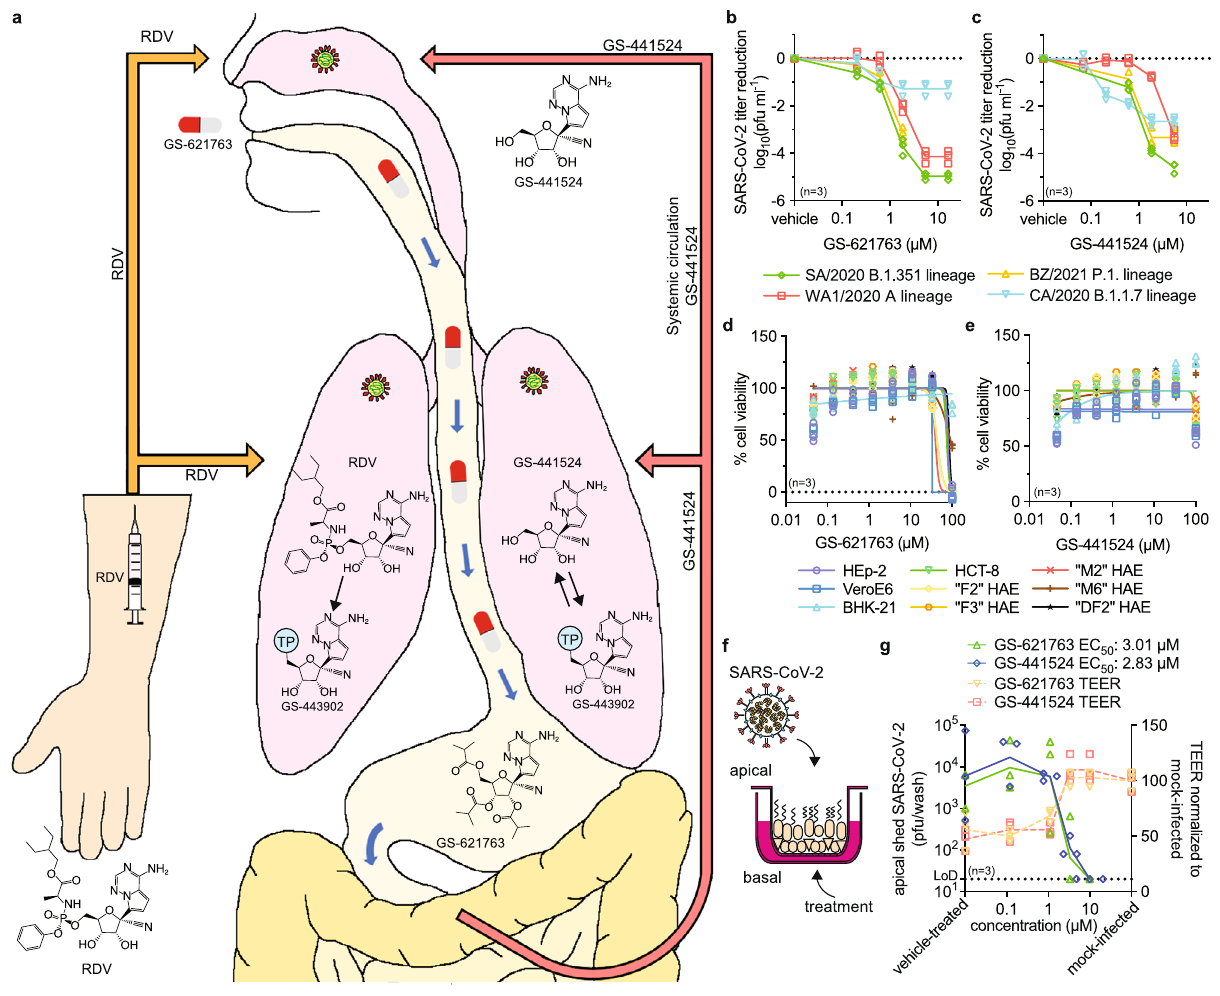
Fig. 1 Antiviral potency of remdesivir analog GS-621763. a Schematic depicting metabolism of remdesivir (RDV; orange arrows) and GS-621763 (red/white pills; red arrows) after injection or oral uptake, respectively. Remdesivir distributes into tissues (e.g., lung) and is ef fi ciently metabolized intracellularly to GS-443902 (TP = triphosphate). Conversely, GS-441524 is the dominant plasma metabolite after intestinal absorption of orally administered GS-627163 and is subsequently anabolized to GS-443902 in the tissues. b – c Virus yield reduction of SARS-CoV-2 clinical isolates WA1/ 2020 (red squares), CA/2020 (blue triangles), SA/2020 (green diamonds), and BZ/2021 (yellow triangles) representing the A, B.1.1.7 ( α ), B.1.351 ( β ) and P.1 ( γ ) lineages, respectively, by GS-621763 (b) and GS-441524 (c) on VeroE6 cells. EC 50 concentrations are speci fi ed in Supplementary Table 1. d – e In vitro cytotoxicity pro fi les of GS-621763 (d) and GS-441524 (e) on VeroE6 (blue squares), HEp-2 (purple circles), BHK-21 (light blue triangles), HCT-8 (green triangles) and a panel of primary HAE cells from independent donors ( “ F2 ” (yellow diamonds), “ F3 ” (orange circles), “ M2 ” (red “ × ” symbols), “ M6 ” (brown “ + ” symbols), “ DF2 ” (black stars)). f schematic of well-differentiated air-liquid interface HAE cultures. g HAEs were infected from the apical side with SARS-CoV-2 VOC γ and treated from the basolateral side with GS-621763 or GS-441524. Apically shed virus titers (green triangles and blue diamonds for GS-621763 or GS-441524, respectively) on day after infection and the impact of treatment on preserving tissue integrity (transepithelial electrical resistance (TEER) (orange triangles and red squares for GS-621763 or GS-441524, respectively) are shown. LoD, the limit of detection. In ( b – e, g ), symbols represent individual biological repeats ( n = 3), lines ( b – c, g ) intersect the mean, lines in ( d – e ) depict nonlinear regression Therapeutic ef fi cacy and lowest ef fi cacious dose . To determine 621763 at 3 mg/kg plateaued approximately one order of mag- the lowest ef fi cacious dose in a clinically more relevant ther- nitude lower than in those from vehicle animals, while treatment apeutic setting, we initiated oral treatment 12 h after infection, with GS-621763 at 10 mg/kg or EIDD-2801/molnupiravir when the shed virus is fi rst detectable in nasal lavages, at the reduced shedding to near-detection level by day 3 after infection. 10 mg/kg and 3 mg/kg body weight levels, administered b.i.d. Consistent with this inhibitory effect, treatment with 3 mg/kg GS- (Fig. 3a). EIDD-2801/molnupiravir at 5 mg/kg b.i.d. was given as 621763 reduced burden in the turbinates by one order of mag- reference following an identical therapeutic b.i.d. regimen 6 . nitude (Fig. 3c), while virus burden approached the limit of EIDD-2801 was included as a reference compound, since at the detection in animals of the 10 mg/kg GS-621763 and EIDD-2801/ time of study EIDD-2801 was the only nucleoside analog with molnupiravir treatment groups. No signi fi cant differences in demonstrated oral ef fi cacy against SARS-CoV-2 in the ferret clinical signs were noted between vehicle animals and any of the model. Shed virus load was signi fi cantly lower in all treated treatment groups (Fig. 3d, e). animals than in the vehicle group within 12 h of treatment onset Viral RNA was detectable in nasal lavages and turbinates of all (Fig. 3b). Virus load in nasal lavages of ferrets receiving GS- animals, underscoring ef fi cient infection. However, RNA copies